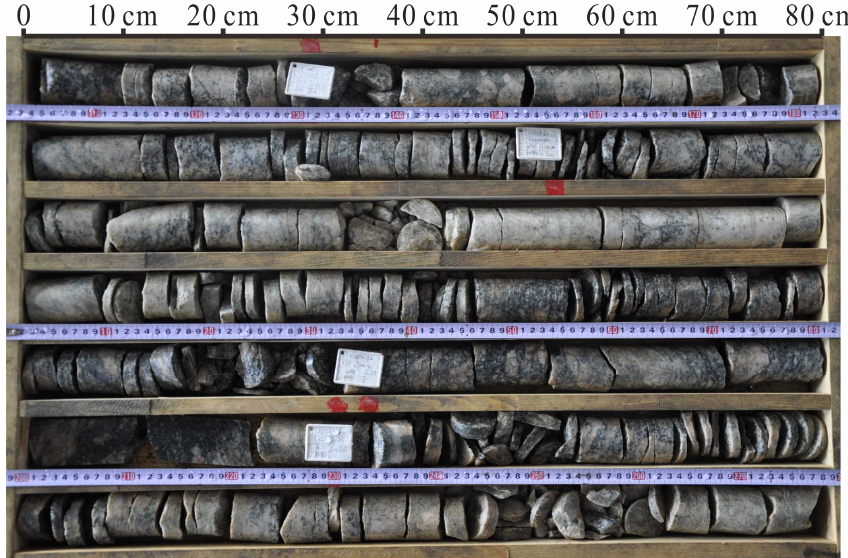
Figure 2. Drilling cores of the study area.